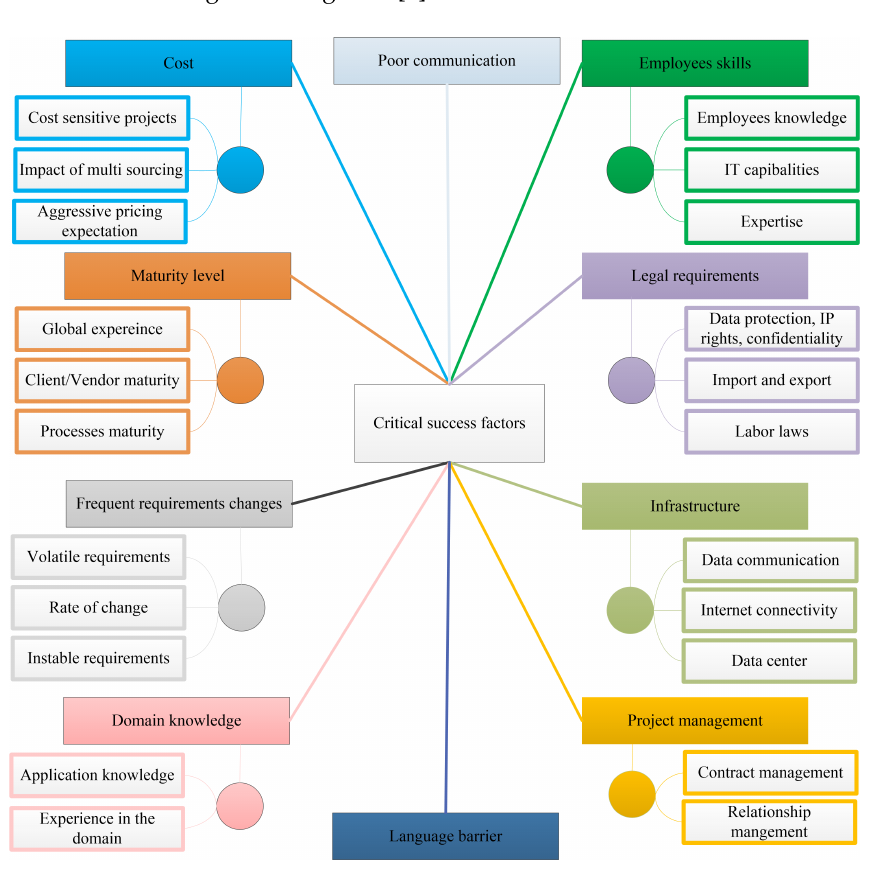
Figure 3. List of the identified critical success